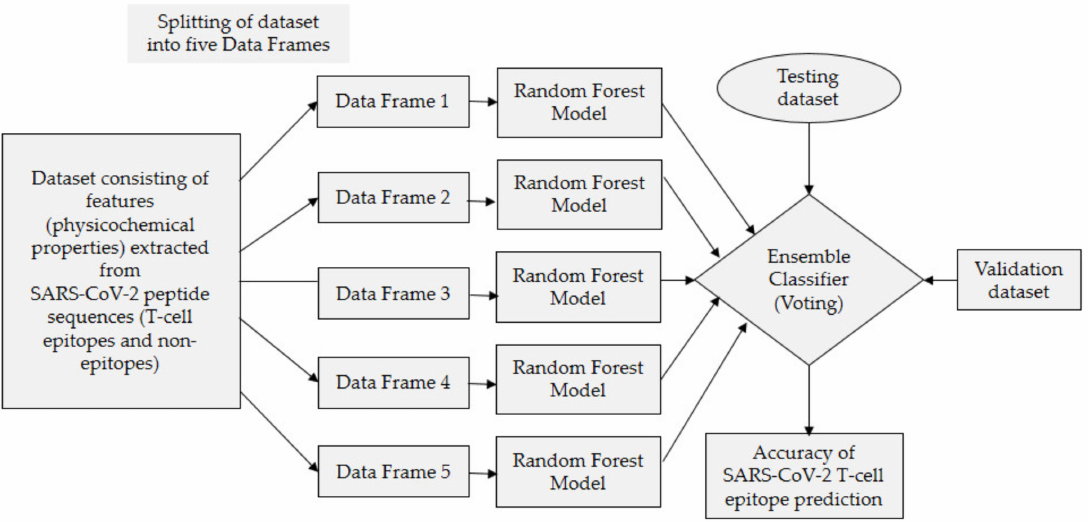
Figure 2. Proposed ensemble